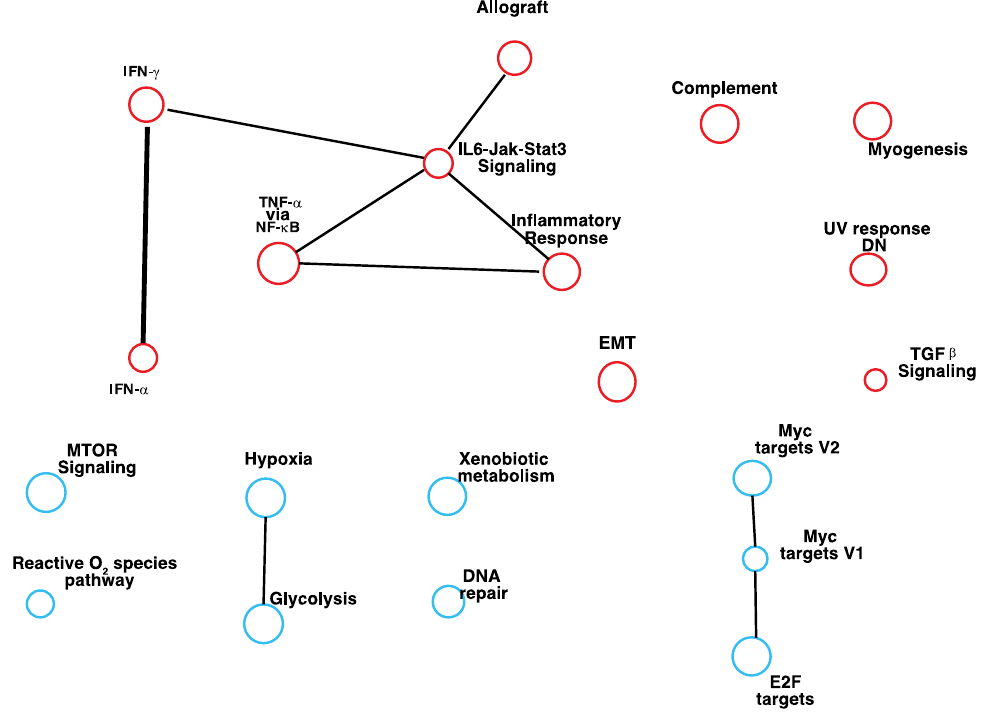
Figure 1. Expression of immune response gene sets correlates with RKIP expression in cultured mouse cancer cells. Cytoscape Enrichment Map with each node (circle) represents a gene set with the indicated biological state. The expression levels of each gene set can be either upregulated (red) or downregulated (blue) in response to reduced RKIP expression. Gene sets with shared genes are linked by edges (dark lines) with thicknesses that correspond to the number of genes in common between two sets. The overlap coefficient was set at 0.2, so that the edges are shown for sets that have about 20% shared genes. Only gene sets with FDR < 0.1 and p < 0.03 are shown.